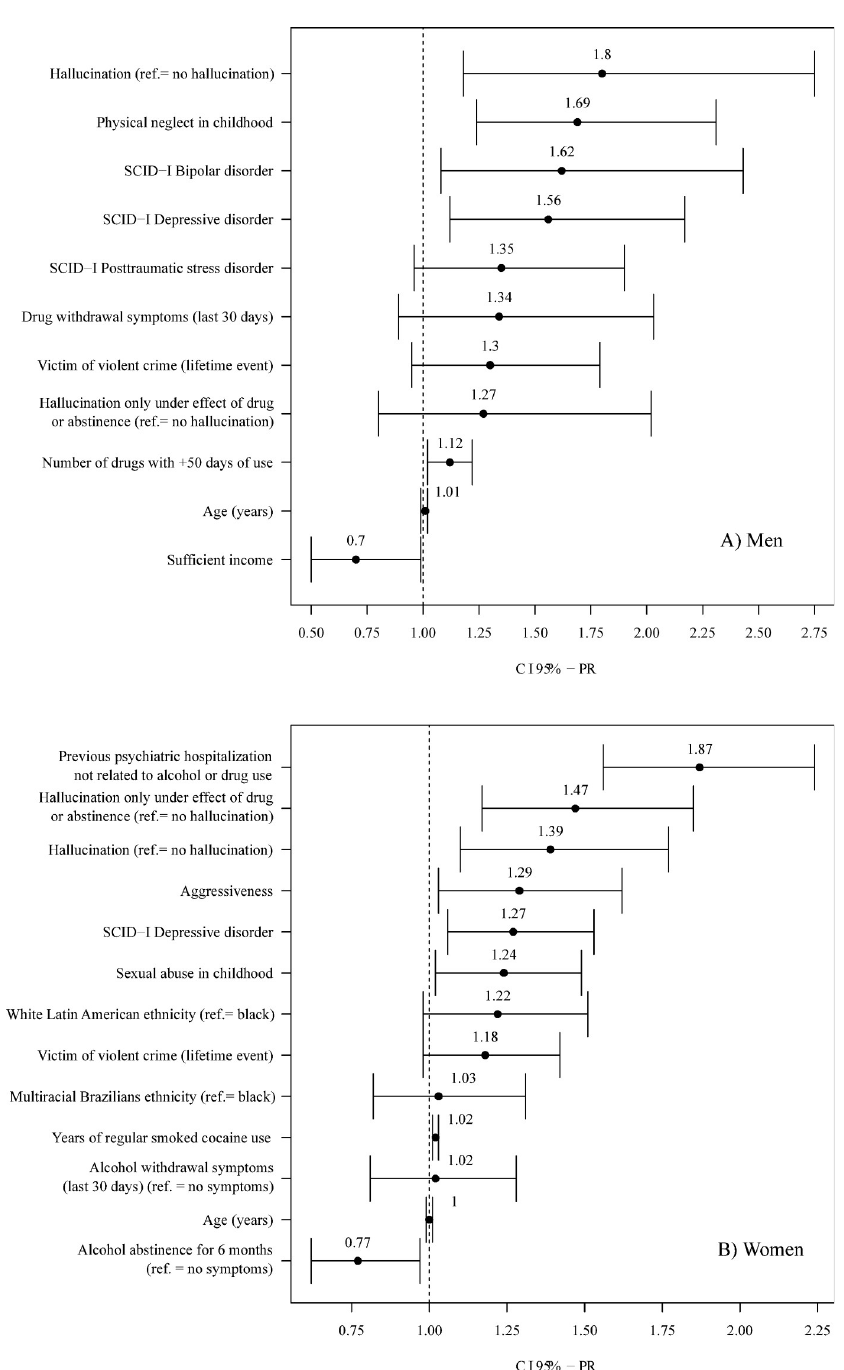
Fig 1. Prevalence ratios and 95% confidence intervals of lifetime suicide attempt for the variables in the multiple poisson regression models among men (A; n = 246) and women (B; n = 402) crack-cocaine inpatient users. The remaining variables in the last step of the backward elimination are shown. Variables with no indication of reference category (ref.) are binary ( yes/no ), and their reference category is no . https://doi.org/10.1371/journal.pone.0232242.g001 on the test data of the Random Forest fitted models for (A) men and (B) women. The AUCs were better than random in both cases (AUC = 0.680 and AUC = 0.734). M W